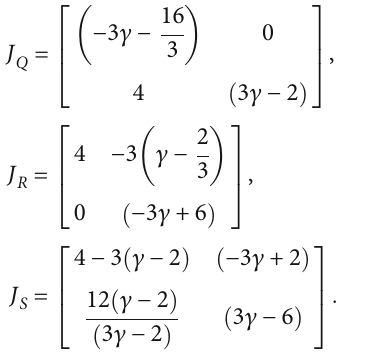
The eigenvalues of the Jacobian matrix at the respec- tive fi xed points and their stability analysis are shown in Table 1. For the fi xed point Q , both eigenvalues become negative